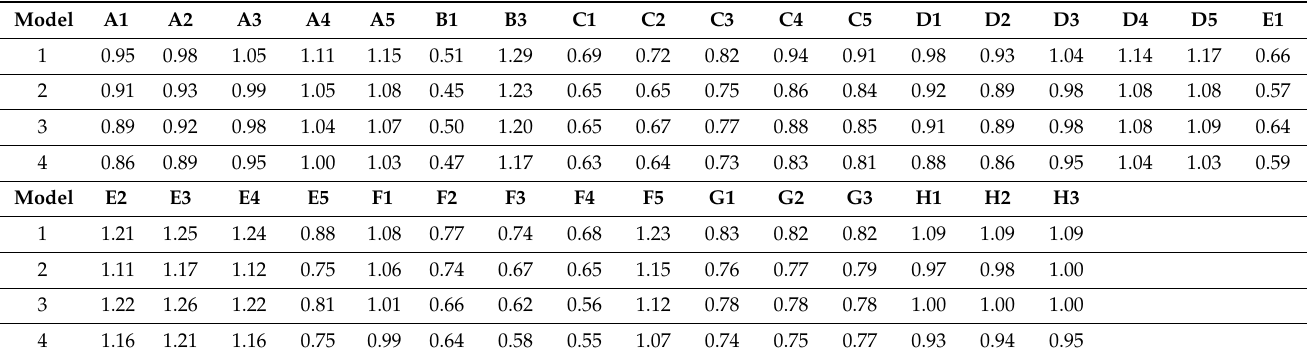
Table 3. Results, average value, and sum of displacements in the Y direction at characteristic measurement points, obtained in the numerical simulation of the welding process of the furnace wall panel.